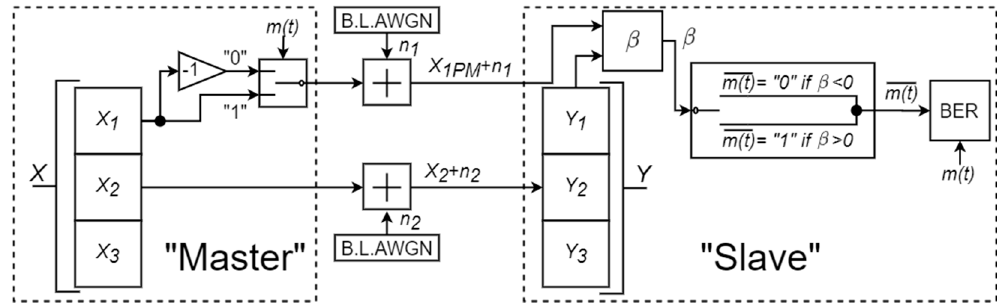
Figure 9. Block diagram of the proposed communication system’s experimental study in the additive white Gaussian noise (AWGN) propagation channel.